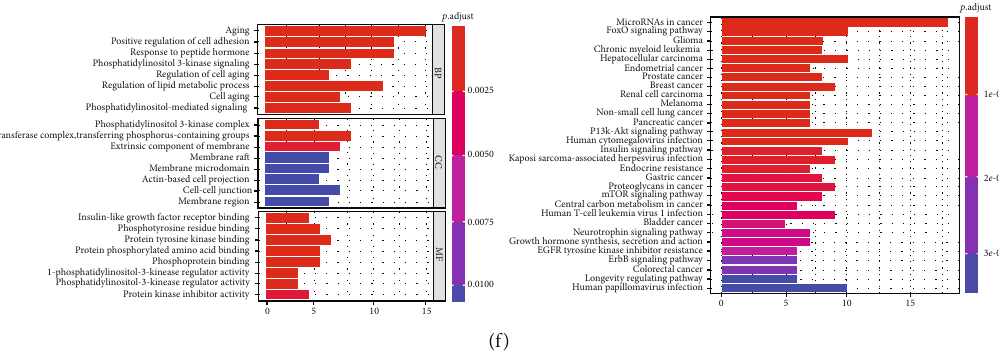
Figure 1: EVs were successfully isolated from hepatoblastoma tissues. (a) The separation e ffi ciency of EVs was examined by TEM. (b) The particle sizes of EVs derived from cancer and normal tissues were measured by NTA. (c) CD9, CD63, CD81, and CD326 levels in EVs1 and EVs2 were assessed by western blot. β -Actin was applied for normalization. ∗ P < 0 : 05 compared to EVs1. (d) The ratio of CD44+ CD90+ CD133+ cells in normal and tumor tissues was assessed by fl ow cytometry. ∗ P < 0 : 05 compared to normal tissue. (e) The miRNA-mRNA network in hepatoblastoma was presented. (f) The target of overlapped miRNAs was subjected to GO and KEGG